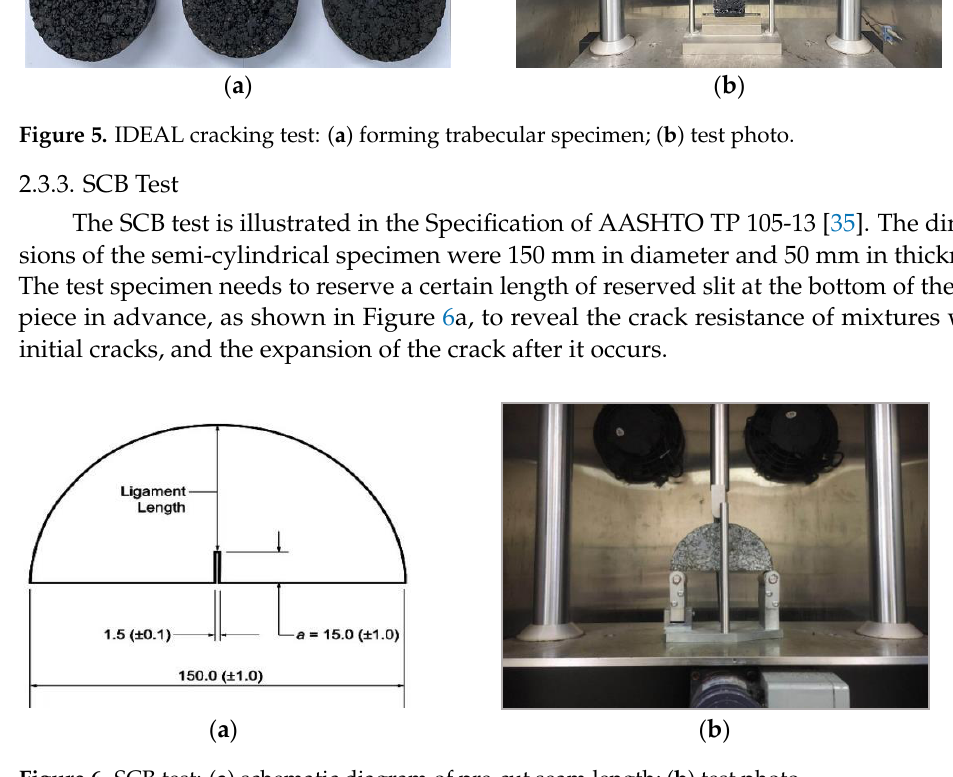
Figure 7. SCB test load-displacement curve.